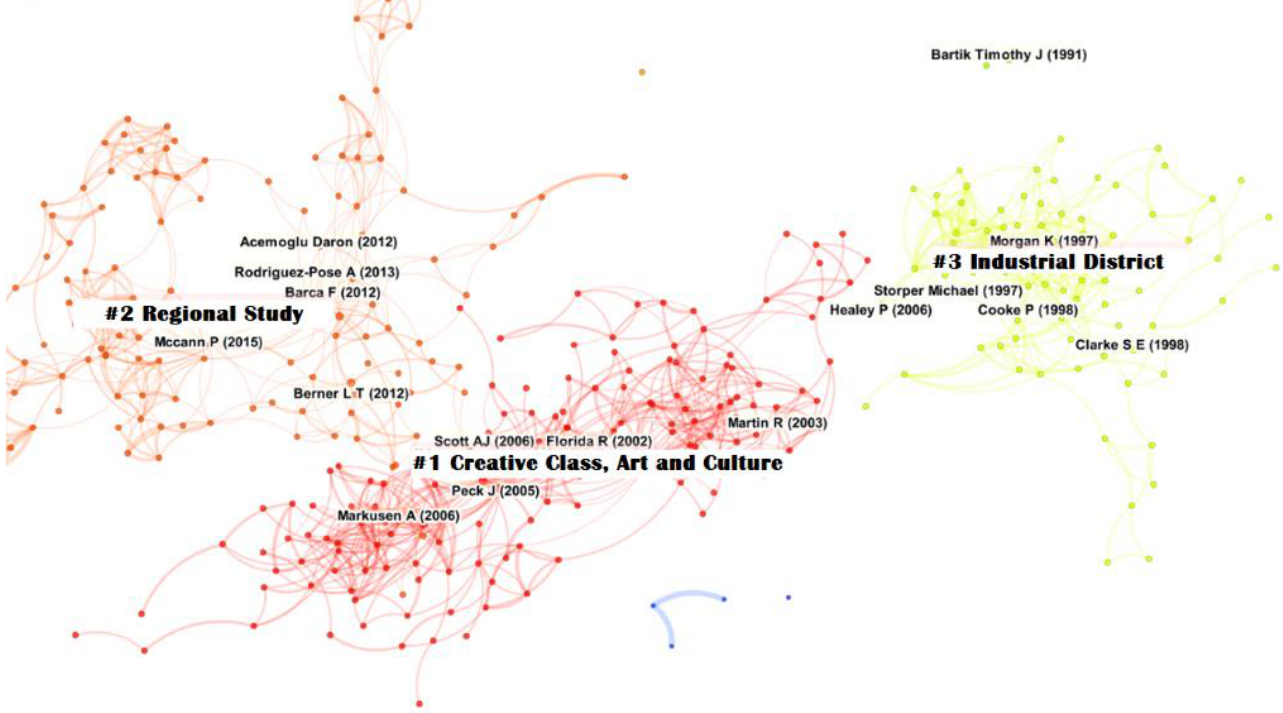
Figure 3. Three major citation clusters.